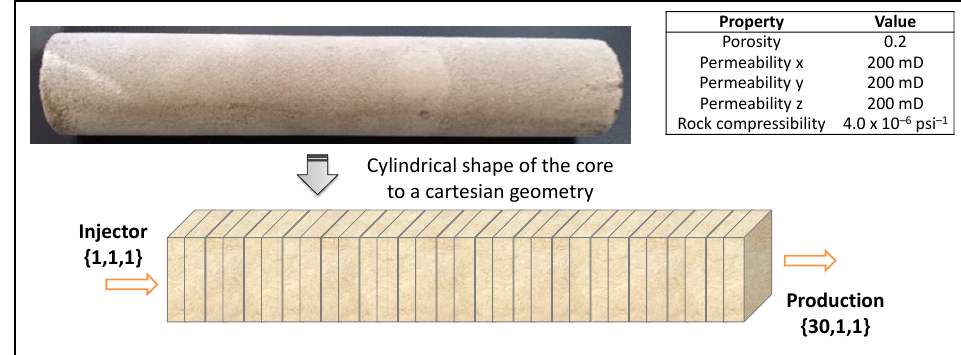
Figure 1. Schematic diagram of the simulation grid indicating the injector well and production well.